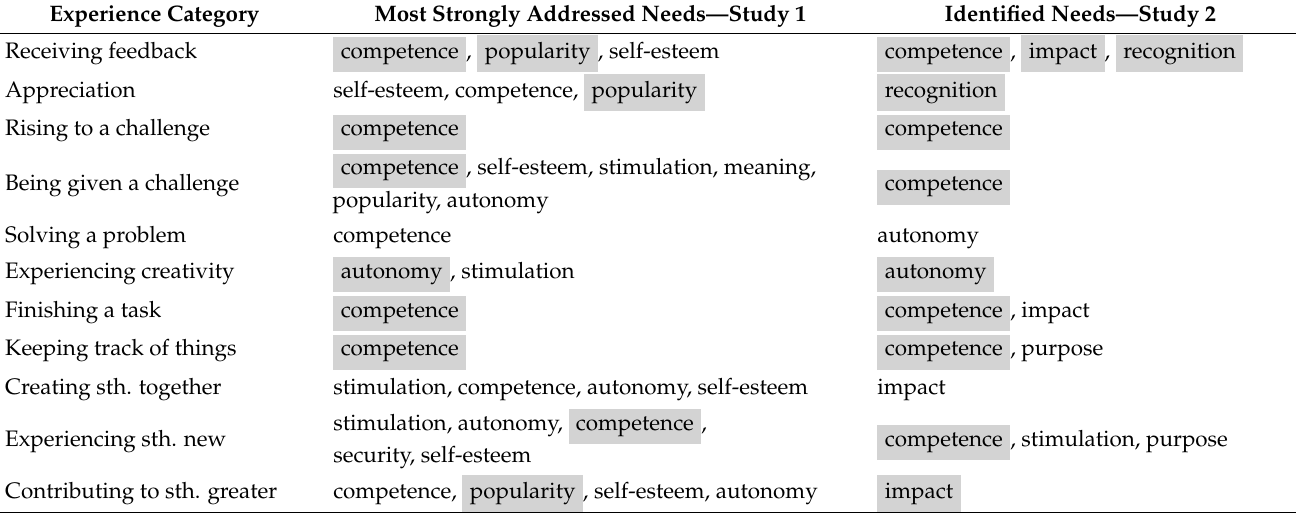
Table 10. Comparison of the needs assigned to experience categories in Studies 1 and